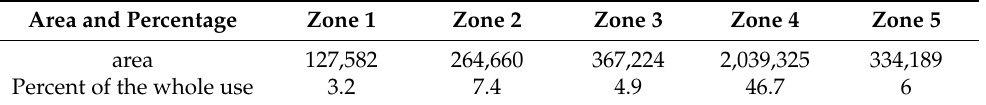
Table 3. Area and the percentage of green space, gardens and agricultural land in the zones of Sanandaj city (2014).